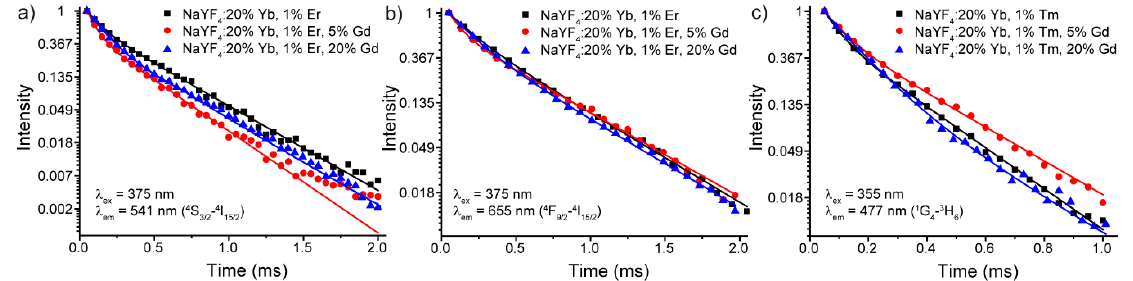
Figure 8. Decay curves of NaYF 4 : 20% Yb, 1% Er/1% Tm, Gd microparticles monitored for ( a ) 4 S 3/2 – 4 I 15/2 (541 nm), ( b ) 4 F 9/2 – 4 I 15/2 (655 nm), and ( c ) 1 G 4 – 3 H 6 (477 nm) transitions.